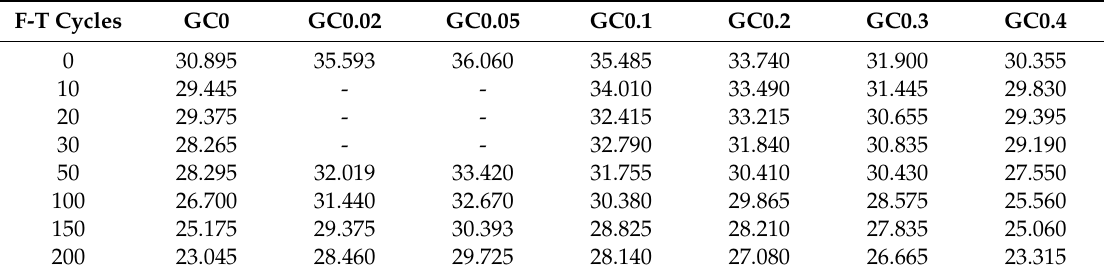
Table 3. Elastic modulus of concrete samples after F-T cycles (unit: